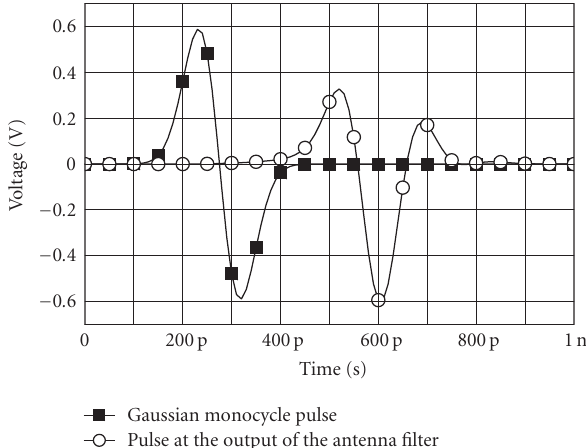
Figure 7: Gaussian monocycle pulse and pulse at the output of the antenna.